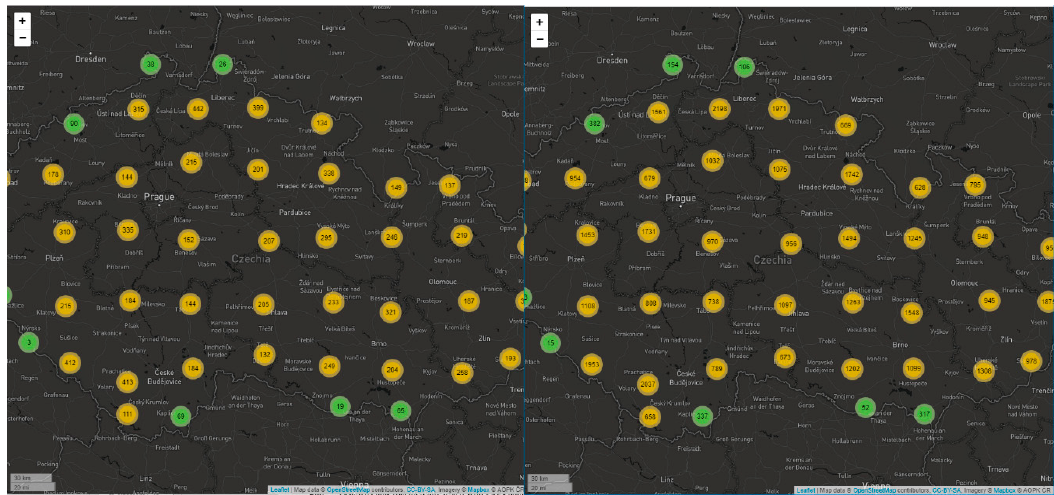
Figure 7. Map output of PruneCluster—testing on 10,000 and 50,000 of points.